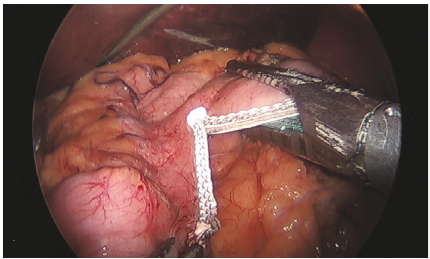
Figure 2: Maintaining a wide berth around bougie at incisura